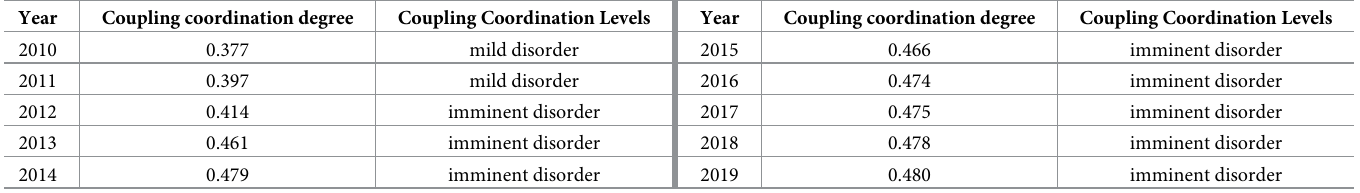
Table 3. Coupling coordination degree of the national energy-economy-carbon emission system from 2010 to